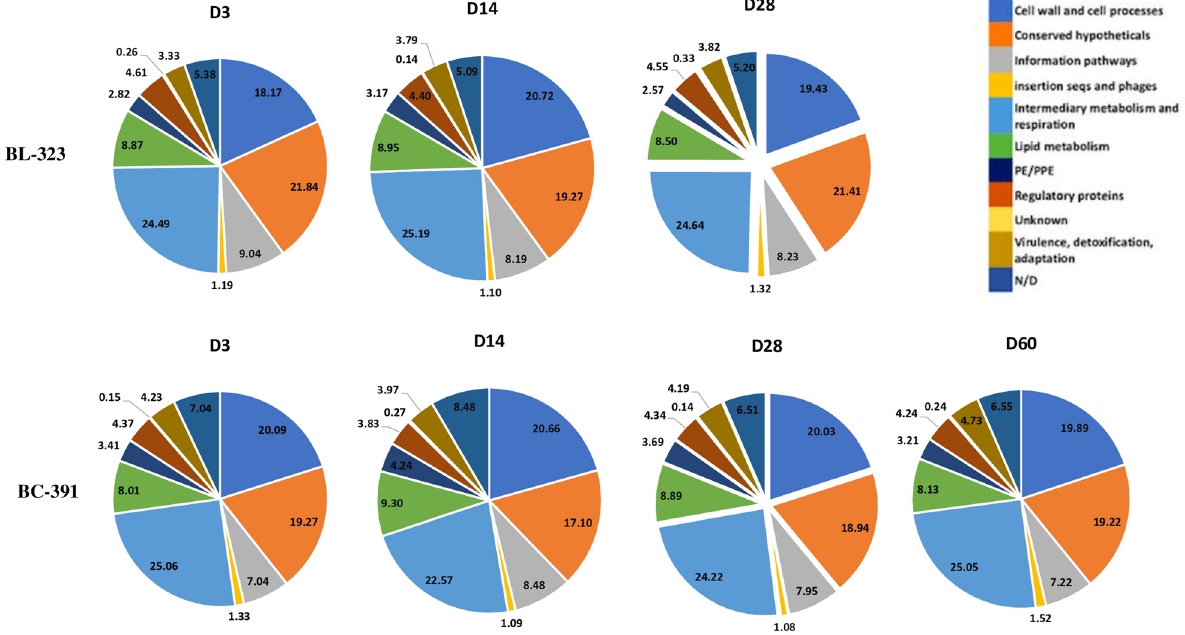
Figure 1. Percentages of mapped reads against the functional categories of MTB (https:// mycobrowser.epfl.ch/ accessed 4 November 2021). The time point of the analysis is showed for both strains. D: day of